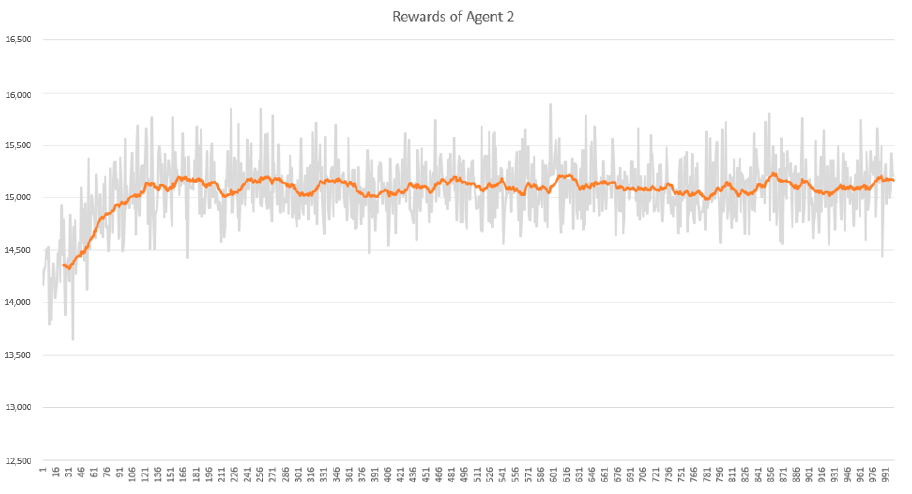
Figure 10. Cumulative reward per episode of agent 2.